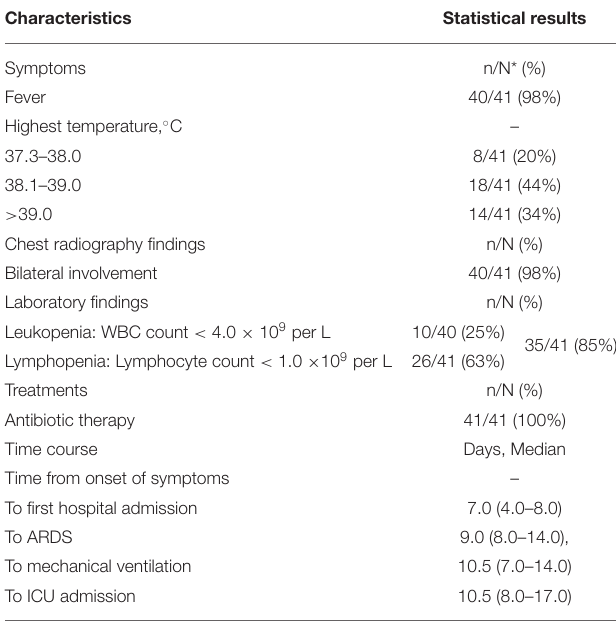
TABLE 3 | Characteristics summary of Middle East Respiratory Syndrome (MERS) patients according to the surveillance guideline for pneumonia with uncertain